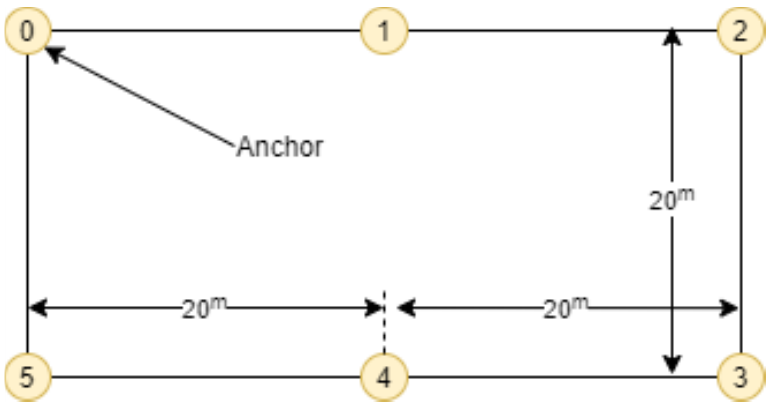
Figure 5. The anchor placement around the tracking